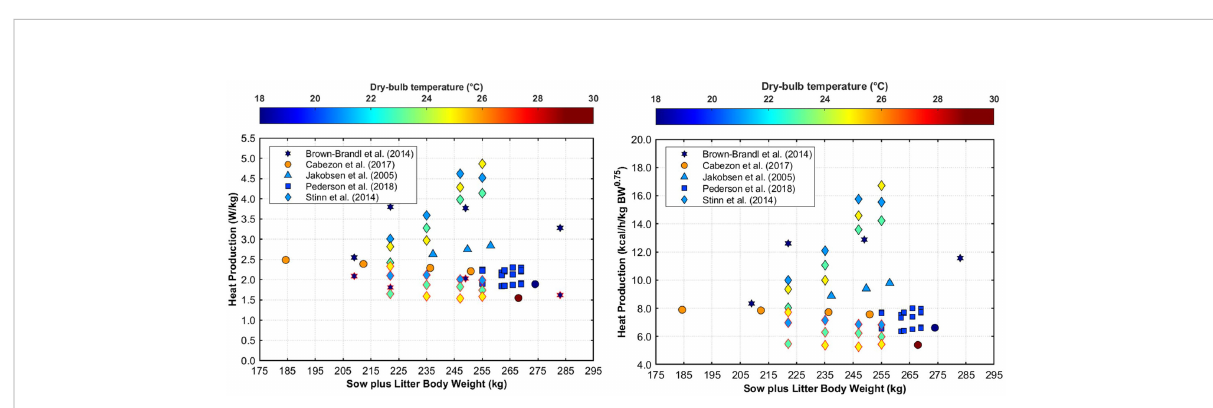
FIGURE 3 Lactating sow plus litter total heat production (black marker outline) and latent heat production (red marker outline) as a function of sow plus litter mass and identi fi ed by reference (marker shape) and reported study temperature (marker color).